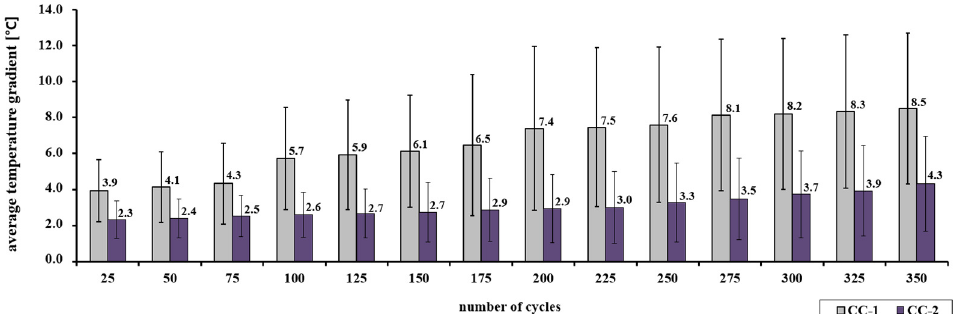
Figure 10. Gradient of the average temperature of the CC-1 and CC-2 concrete depending on the number of thermal cycles.